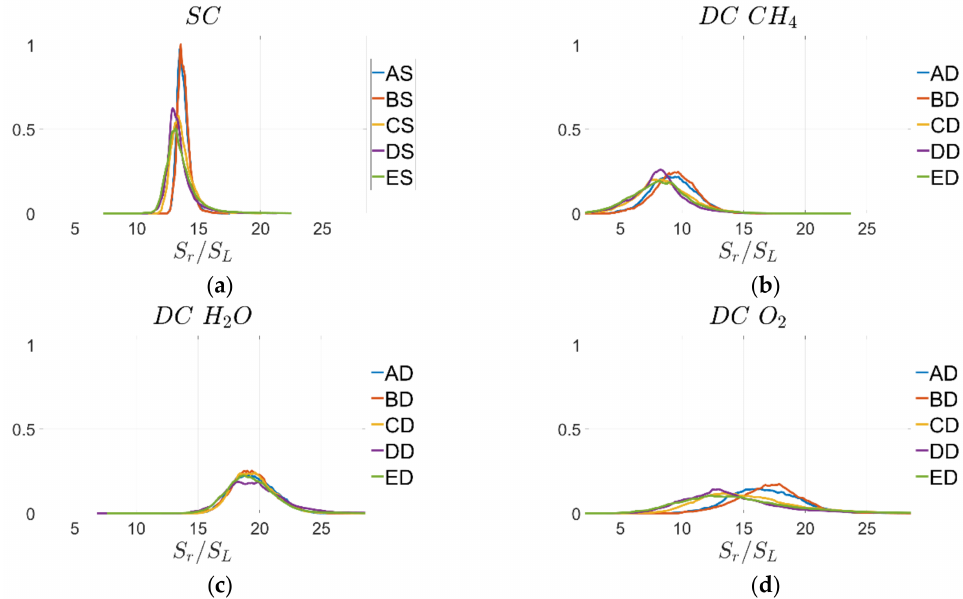
Figure 9. PDF of normalised, reaction component of displacement speed S r / S L on c = 0.8 progress- variable isosurface for cases A–E for ( a ) SC and ( b – d ) DC simulations for reaction progress variable based on CH 4 , H 2 O,O 2 mass